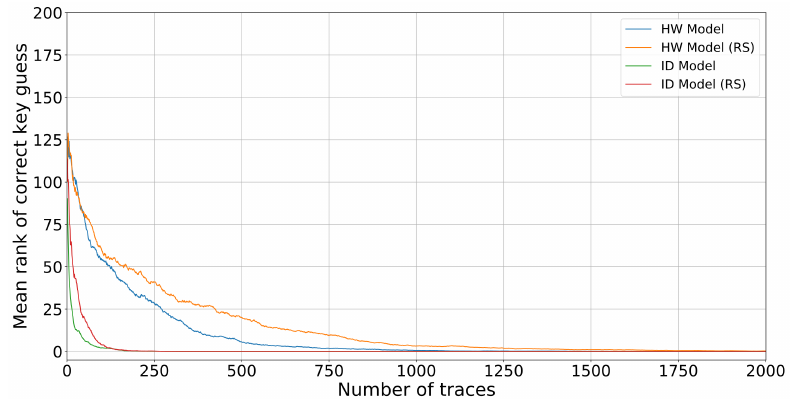
Figure 14: Guessing entropy for the ASCAD fixed key dataset with desynchronization of 50.